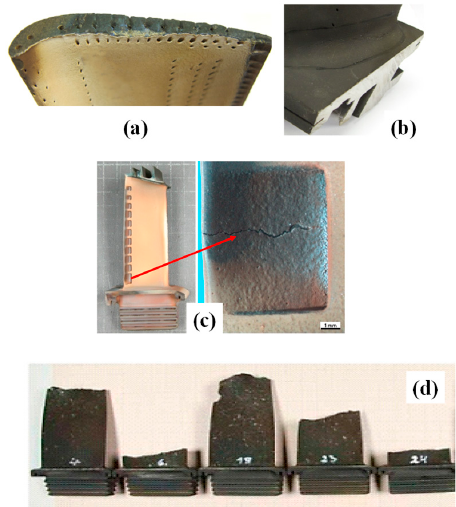
Figure 3. ( a ) Turbine airfoil with worn-out blade tip, ( b ) cracking in the platform section, ( c ) tear in